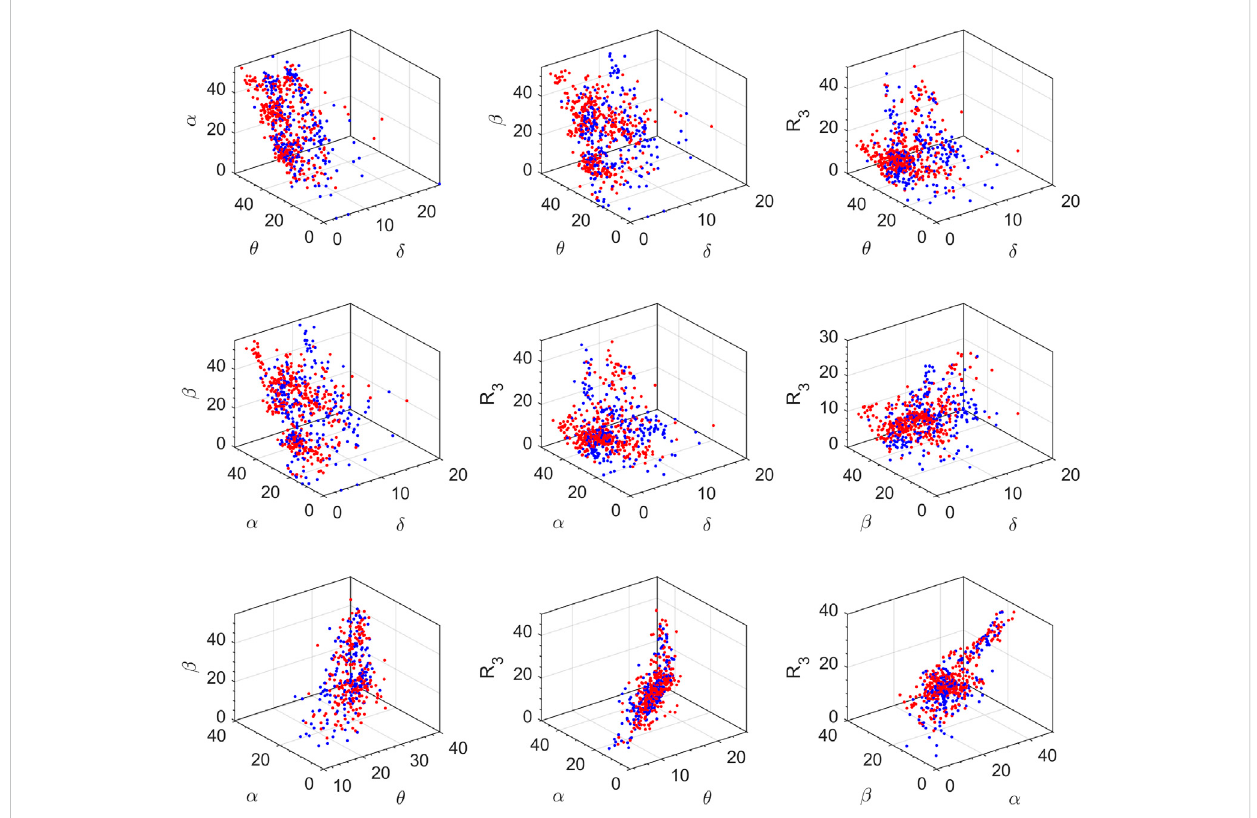
FIGURE 4 3Dscatterplotsonalogscaleforalltheternarycombinationsof fi vetop-rankedfeatures.Redandbluedatapointsrepresentdrowsyandalertstates, respectively (channel F8, all